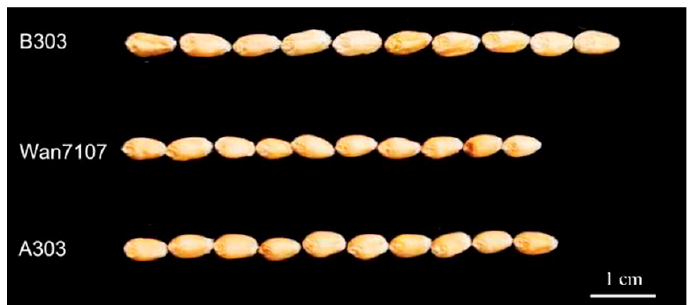
Figure 8. Comparison of grain shape between two translocation lines and Wan7107. To evaluate the effects of the translocations on agronomic traits under PM, the main agronomic traits of three BC 2 F 3 and BC 2 F 4 populations derived from a cross of Pm97033/Wan7107 × 3 planted in a greenhouse were investigated. Plant height, spike length, grain number per spike, floret number, and thousand grain weight of resistant plants were higher than those of susceptible plants, while the numbers of spikelets and sterile floret number in the resistant plants were reduced. However, some traits such as plant height and spike length in two lines of BC 2 F 4 did not show significant differences between the resistant (R) and susceptible (S) plants. Increased sterile floret number in the disease-susceptible plants indicated that the seed setting rate was largely affected by the disease (Table 5). This result is basically consistent with those of the field investigation. Table 5. Comparison of main agronomic traits between resistant and susceptible plants of three BC 2 F 3 and BC 2 F 4 popula- tions derived from a cross of Pm97033/Wan7107 × 3 planted in a greenhouse.